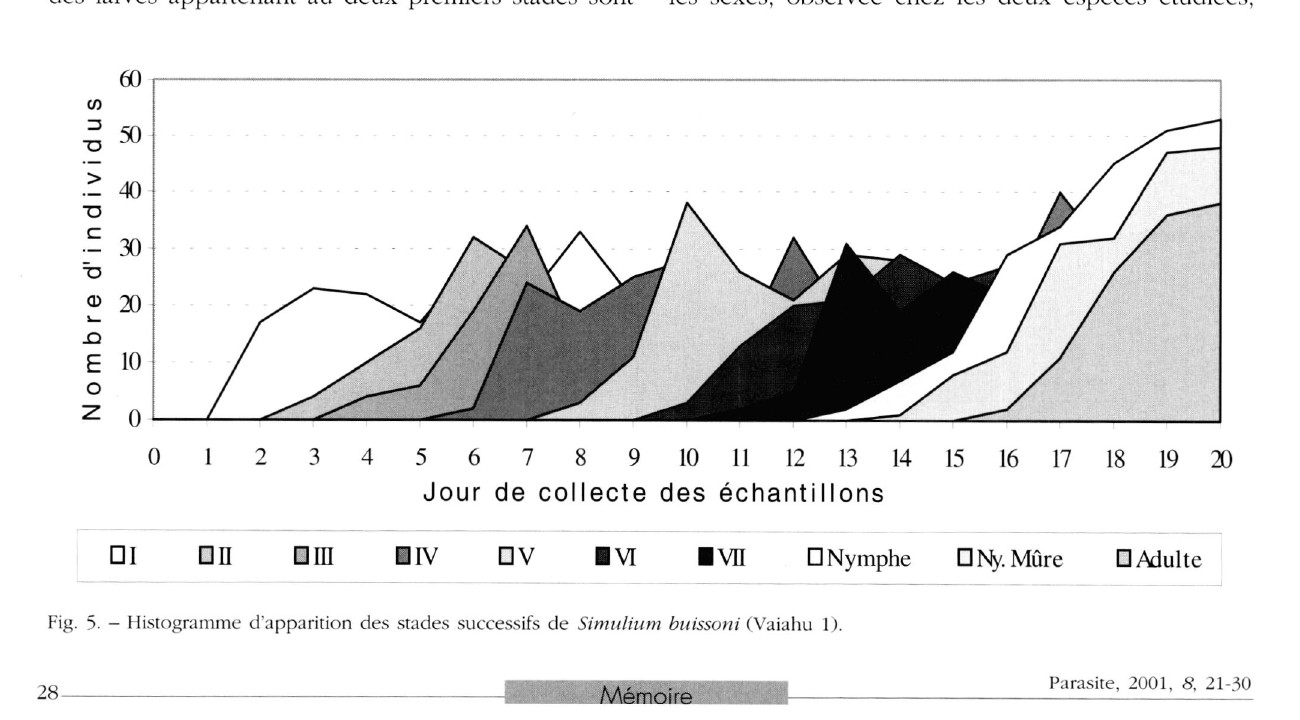
Fig. 5. - Histogramme d'apparition des stades successifs de Simulium buissoni (Vaiahu